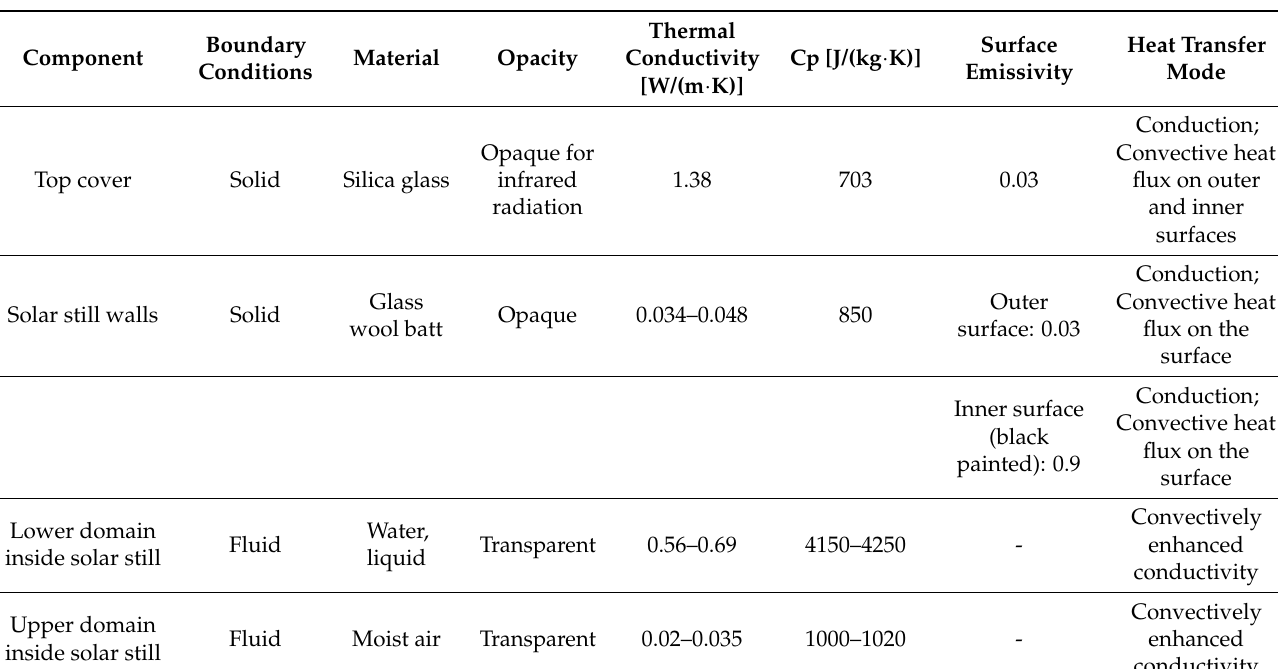
Figure 2. A 3D model of the solar still showing boundary conditions. Table 2. Boundary conditions and material properties .